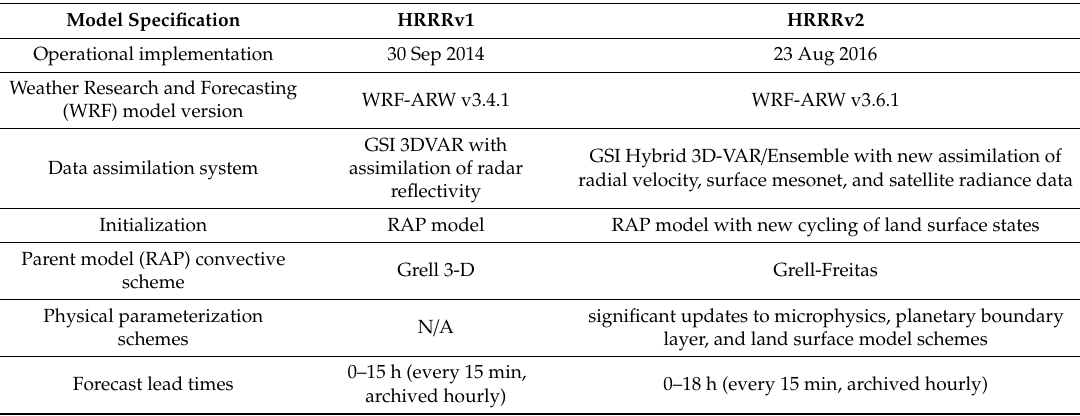
Table 1. High-Resolution Rapid Refresh (HRRR) model version